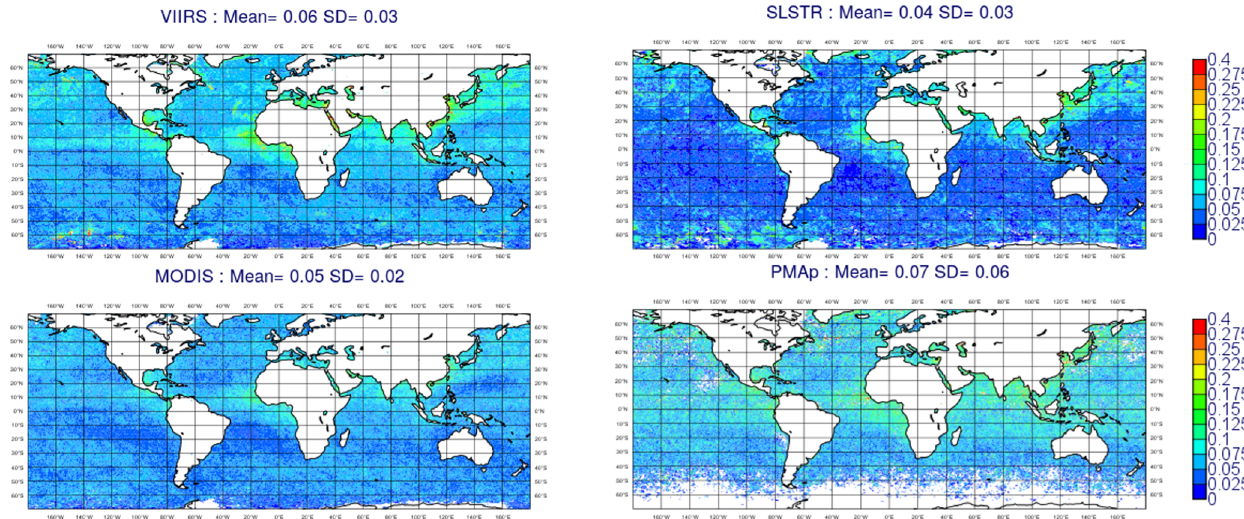
Figure D4. Global maps of the standard deviation of the first-guess departure from Terra and Aqua/MODIS, NOAA20 and SNPP/VIIRS, S3A and S3B/SLSTR, and MetOp-A/B–PMAp for the MAM (2019–2020) period over ocean.